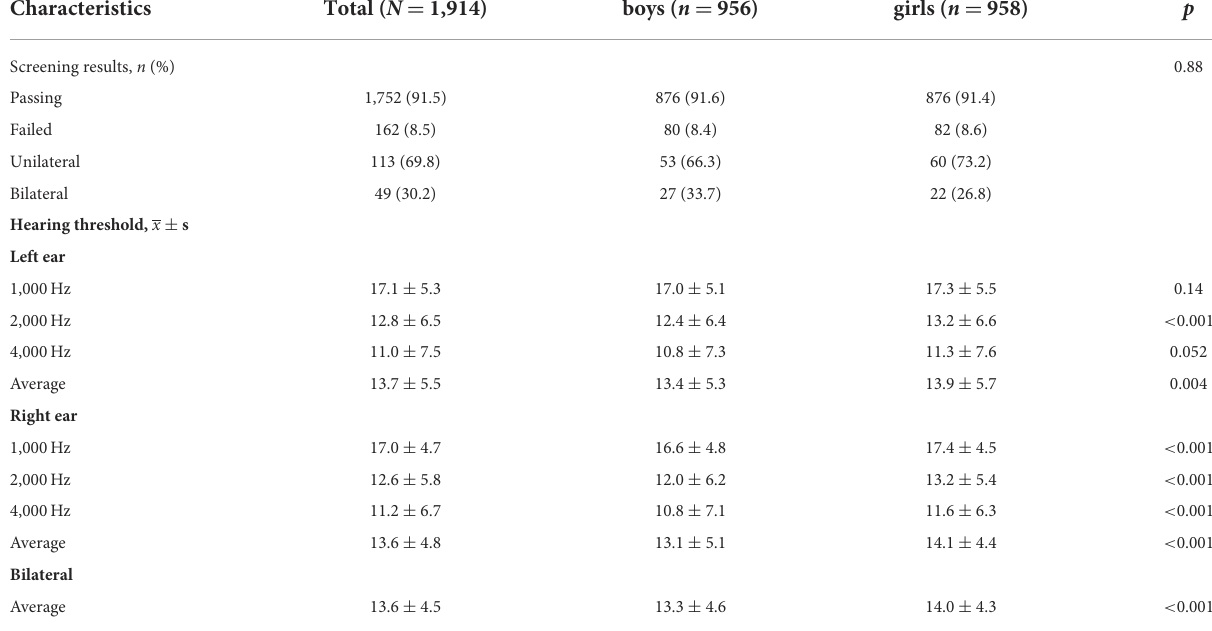
TABLE 2 Hearing screening results among 1,914 children aged 6–8 years in Beijing, China (imputed data).